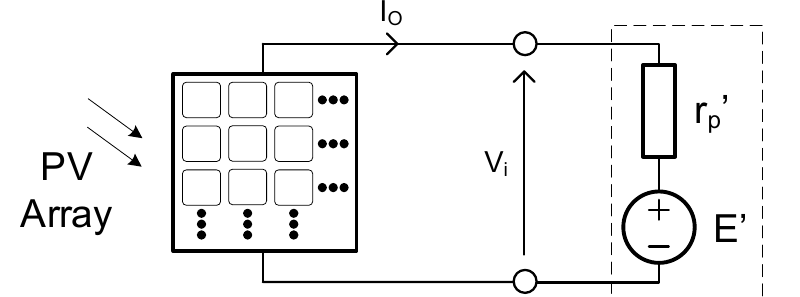
Figure 9. PV array connected to the transferred load.